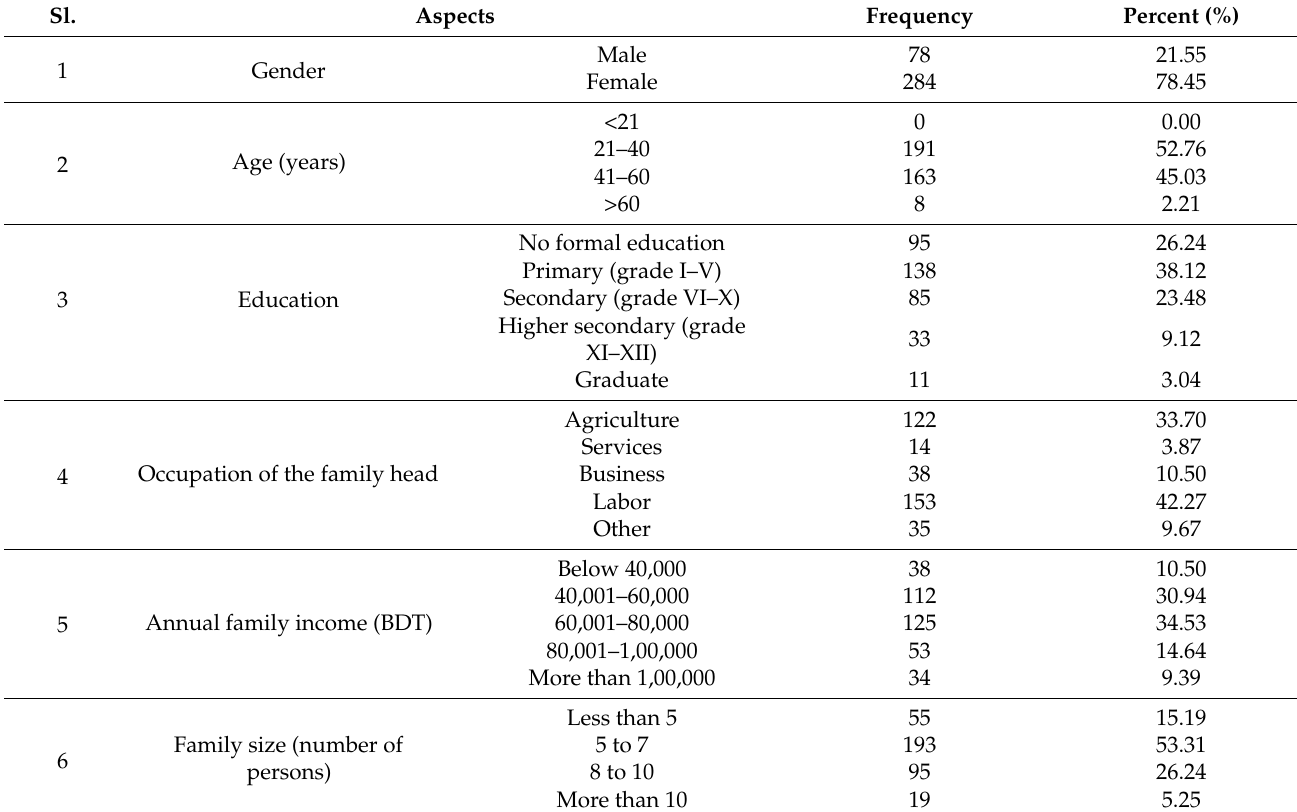
Table 2. Sociodemographic status of the studied households in Southkhali Union.